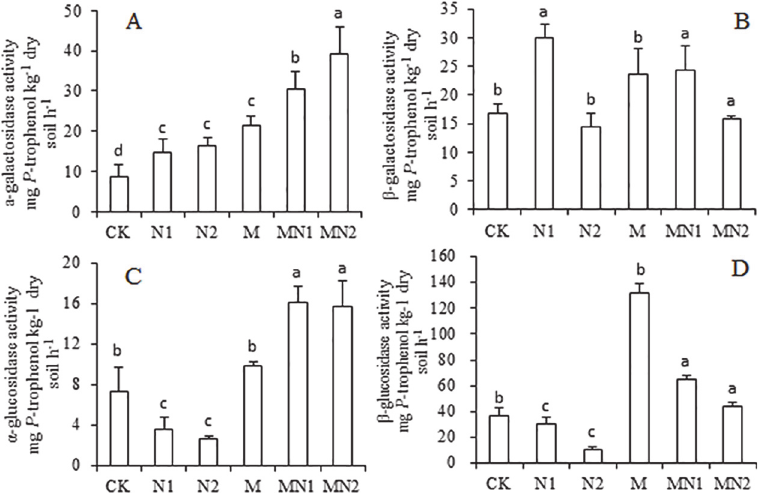
Fig 5. Response of soil a-galactosidase activity (A), β -galactosidase activity (B), α -glucosidase (C), and β -glucosidase activity (D) to the long-term effects of manure and different levels of N fertilization under greenhouse conditions (CK unfertilized control; N1 300 kg fertilizer N ha -1 ; N2 600 kg fertilizer N ha -1 ; M composted manure; MN1 combined application of composted manure and 300 kg N fertilizer ha -1 ; MN2 combined application of manure and 600 kg fertilizer N ha -1 ). Bars designated with the same letters within each panel are not significantly different. P < 0.05 . n =